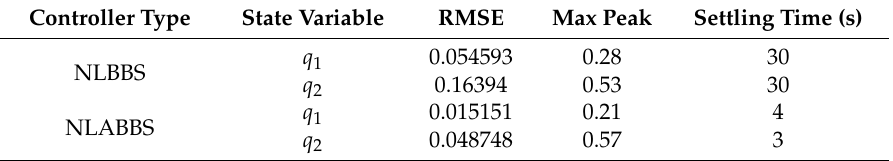
Figure 9. Dynamic responses of the ( a ) cart displacement, and ( b ) ball angular position based on the two controllers under model uncertainty. Table 7. Dynamic performance reports of the ball–arc system based on the two controllers.